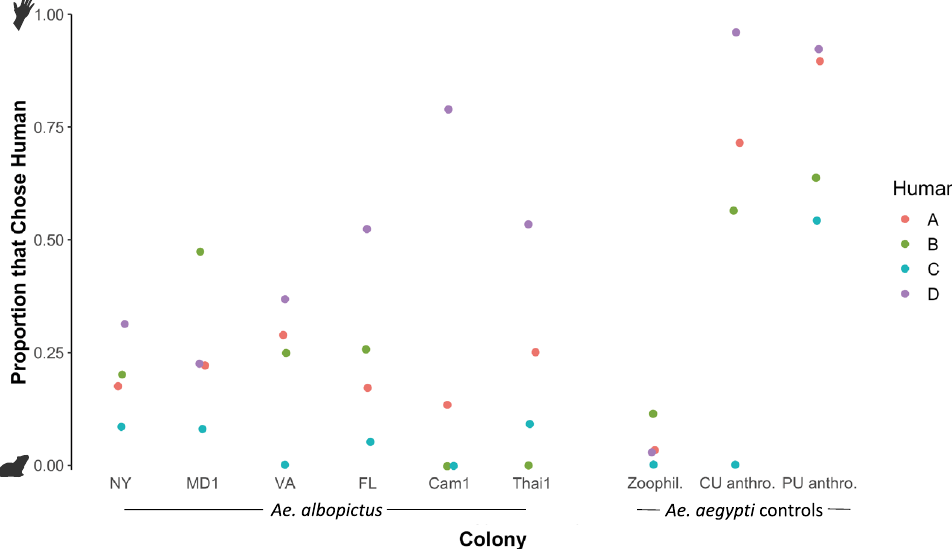
Figure 2. This figure shows the proportion of host-seeking mosquitoes that chose human over guinea pig for each of the colonies. Each point represents the results of one replicate in the first round, with each color representing one of the four human subjects used in this